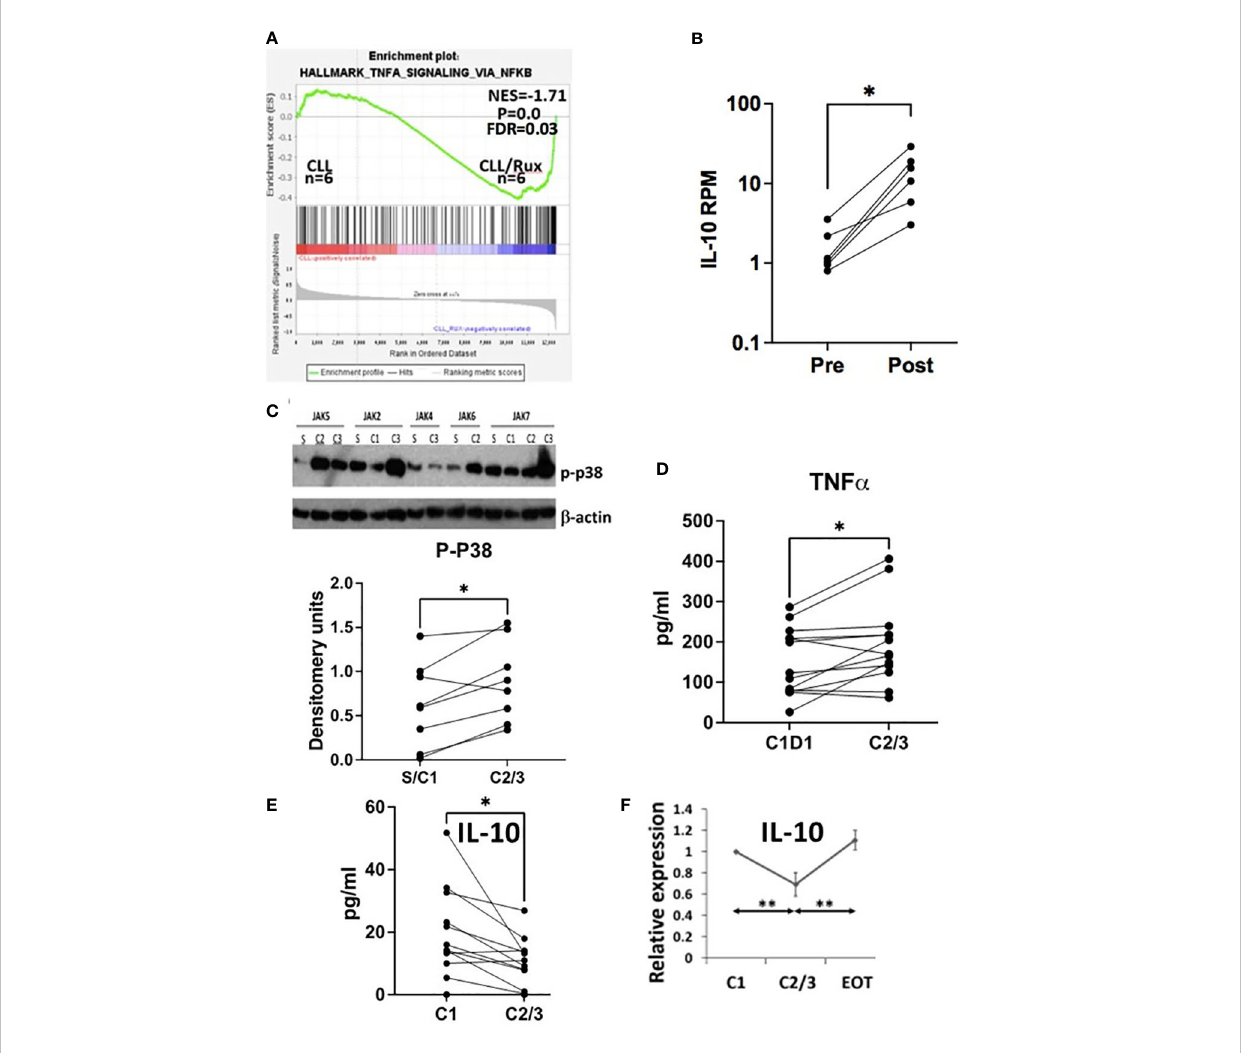
FIGURE 1 Effect of ruxolitinib in vivo . (A) Differentially expressed genes in CLL cells puri fi ed before and during administration of ruxolitinib were analyzed by GSEA. The enrichment plot indicates CLL cells exposed to ruxolitinib in vivo resemble immune cells that have turned up NF k B-activated genes. (B) Number of reads mapped per gene per million reads mapped (RPM) for IL10 are shown in CLL cells isolated from the trial patients before (pre) and while on ruxolitinib (post) with each line representing a single patient. (C) Protein extracts were made from puri fi ed circulating CLL cells at the indicated times after administration of ruxolitinib (S=screening visit; C1=prior to cycle 1; C2=prior to cycle 2; etc.). Phospho-p38 was measured by immunoblotting and densitometry and normalized to b -actin. An example of an immunoblot is shown (top) and the bottom graph